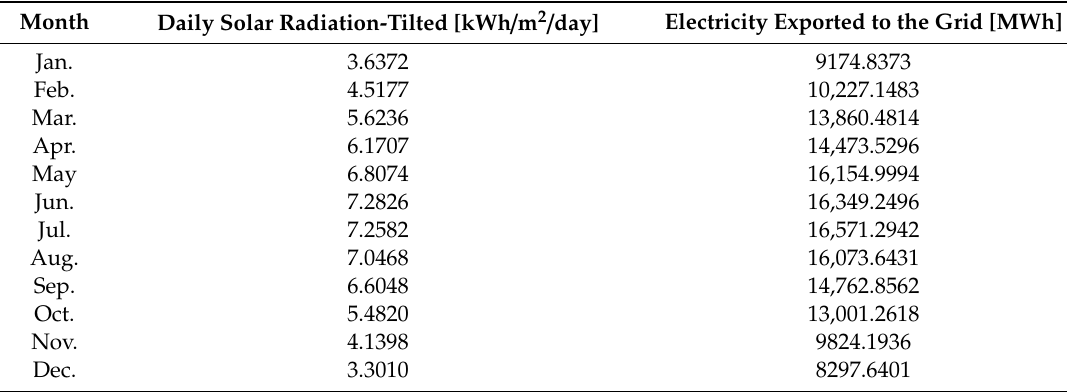
Table 8. Daily solar radiation-tilted and electricity generation.